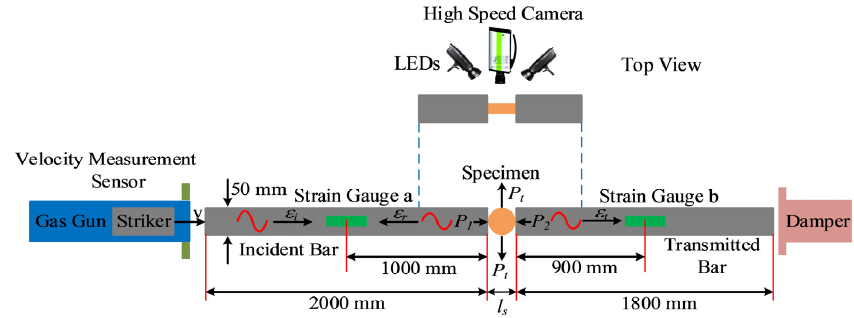
Figure 2. Schematic view of the dynamic Brazilian test under SHPB loading.